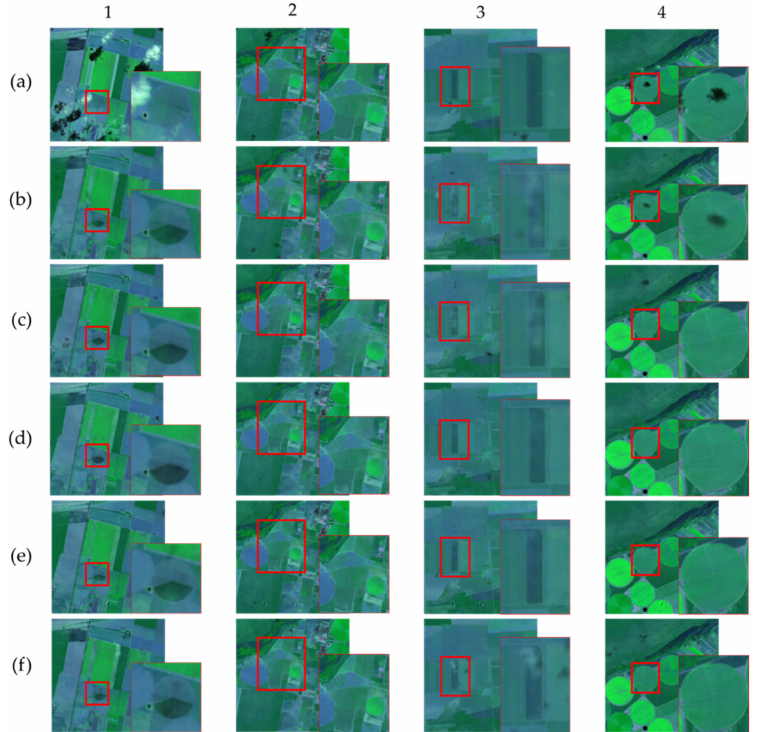
Figure 8. Patches collected over four ( 1 – 4 ) different areas of the testing fields. Patches presented in each row were generated by the same model. Row ( a ) presents the patches collected on the real image, while generated patches produced with pix2pix cGAN with the MLP custom loss function with λ MLP of 0, 100, 200, 300 and 400 are presented in rows ( b – e ), and ( f ),